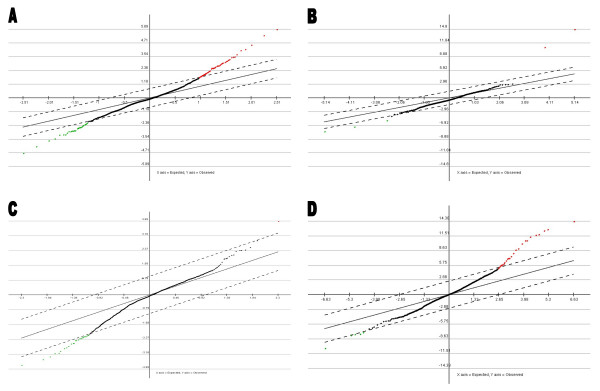
Significance Analysis of Microarrays (SAM) graphs depicting similarities and differences in gene expression between the MCF-7DOX-2(A), MCF-7EPI (B), MCF-7TAX-2 (C), or MCF-7TXT (D) cell lines and their co-cultured parental (MCF-7CC) cell line. Genes not found to be different in expression from MCF-7CC cells are depicted in black, while upregulated and downregulated genes are depicted as red and green dots, respectively.